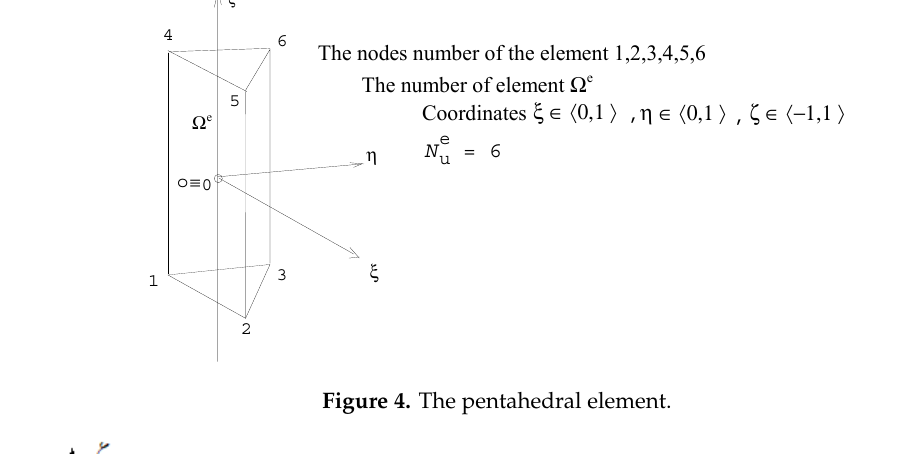
Figure 5. The hexagonal element.